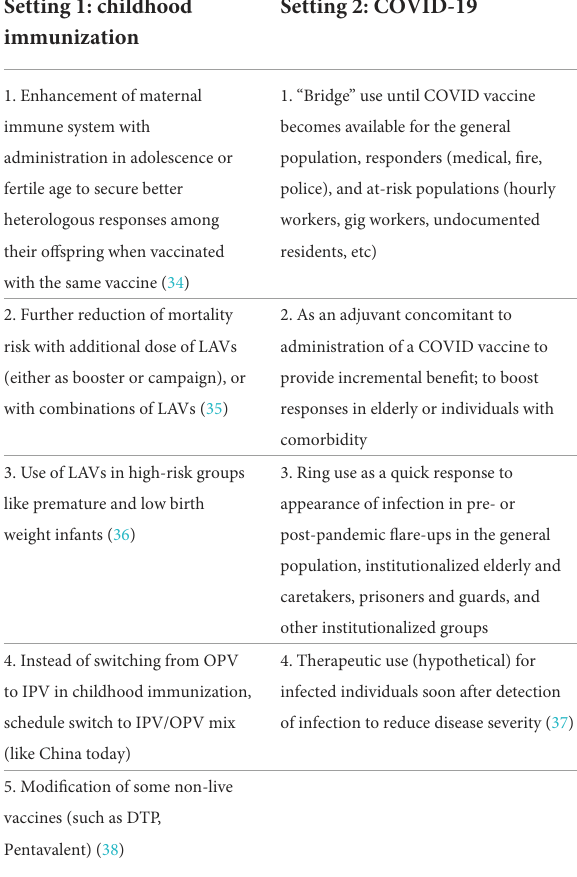
TABLE 3 Potential uses of live attenuated vaccines in the context of childhood immunization and